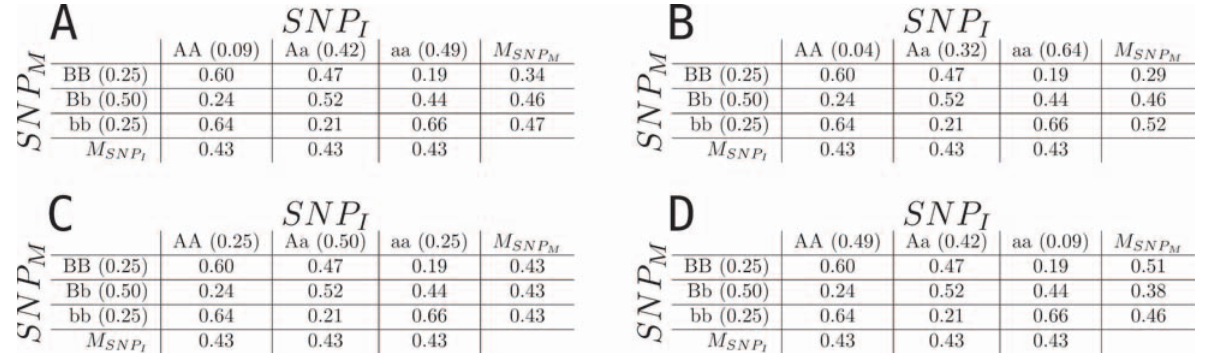
Figure 3. This figure shows marginal penetrances under a number of possible replication scenarios. In part A the marginal penetrances with the allele frequencies found in the discovery phase of a hypothetical genome-wide association study. In part B The marginal penetrances found in the replication phase of a genome-wide association study under a situation where the result would replicate. In part C the marginal penetrances found in the replication phase of a genome-wide association study under a situation where the result would not replicate. In part D the marginal penetrances found in the replication phase of a genome-wide association study under a situation where the allele first discovered as a risk factor would now appear